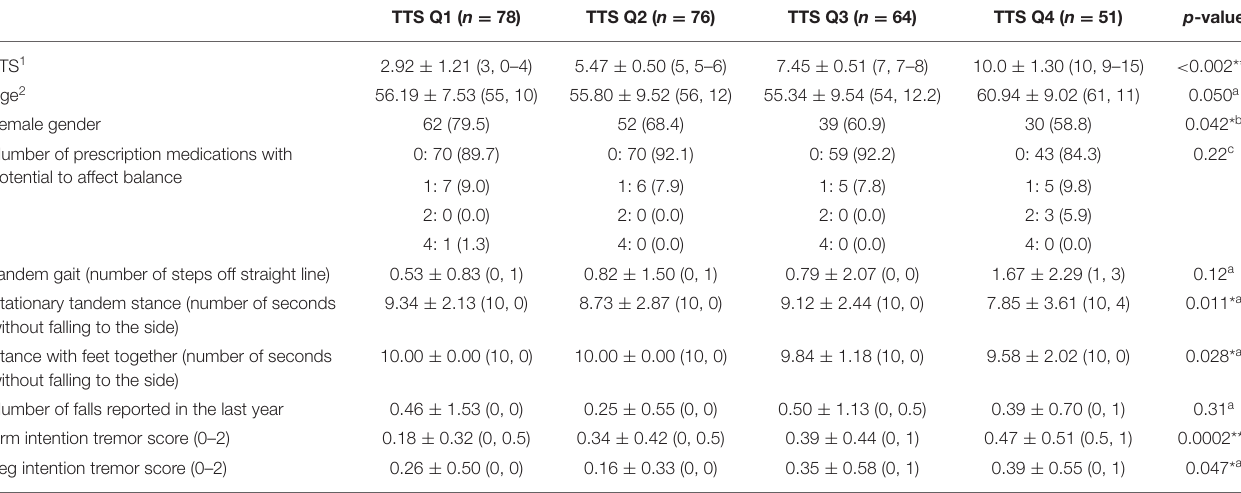
TABLE 3 | Signs of cerebellar dysfunction stratified by TTS